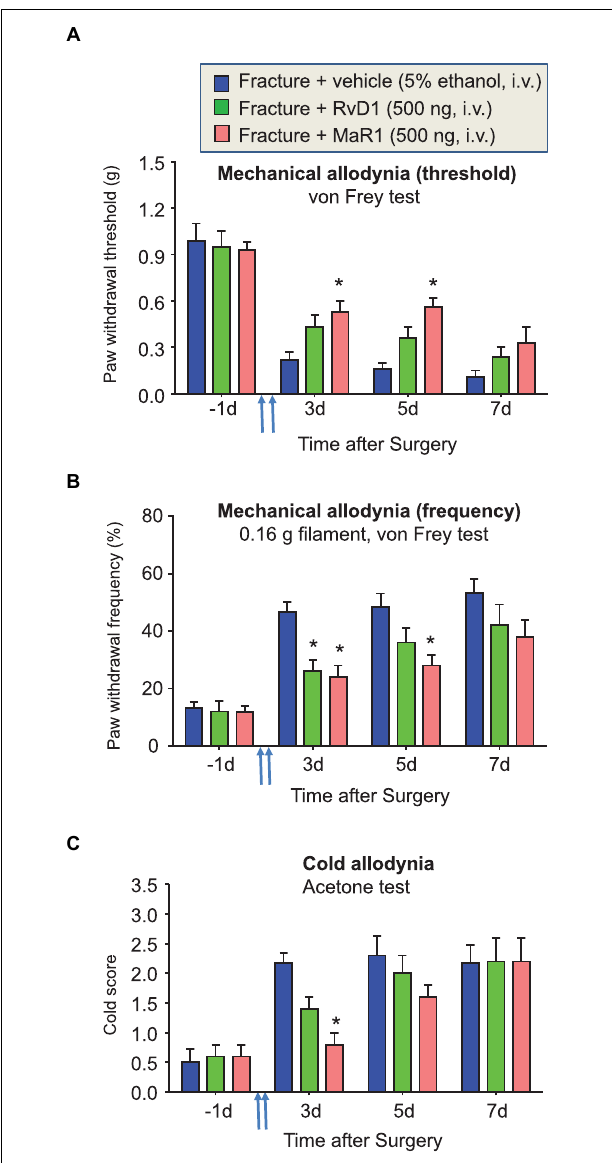
FIGURE 3 | Perioperative treatment of RvD1 and MaR1 attenuates fPOP. Impact of perioperative treatment of RvD1 and MaR1 (500 ng, 100 µ l, i.v.), given 10 min and 24 h after bone fracture surgery (indicated by blue arrows), on mechanical allodynia, assessed by paw withdrawal threshold (A) and paw withdrawal frequency (B) in the von Frey test, as well as on cold allodynia, assessed by cold response scoring in the acetone test (C) . ∗ P < 0.05 vs. vehicle (5% ethanol), two-way ANOVA followed by Bonferroni test, n = 5 mice/group. Data are presented as mean ± SEM.